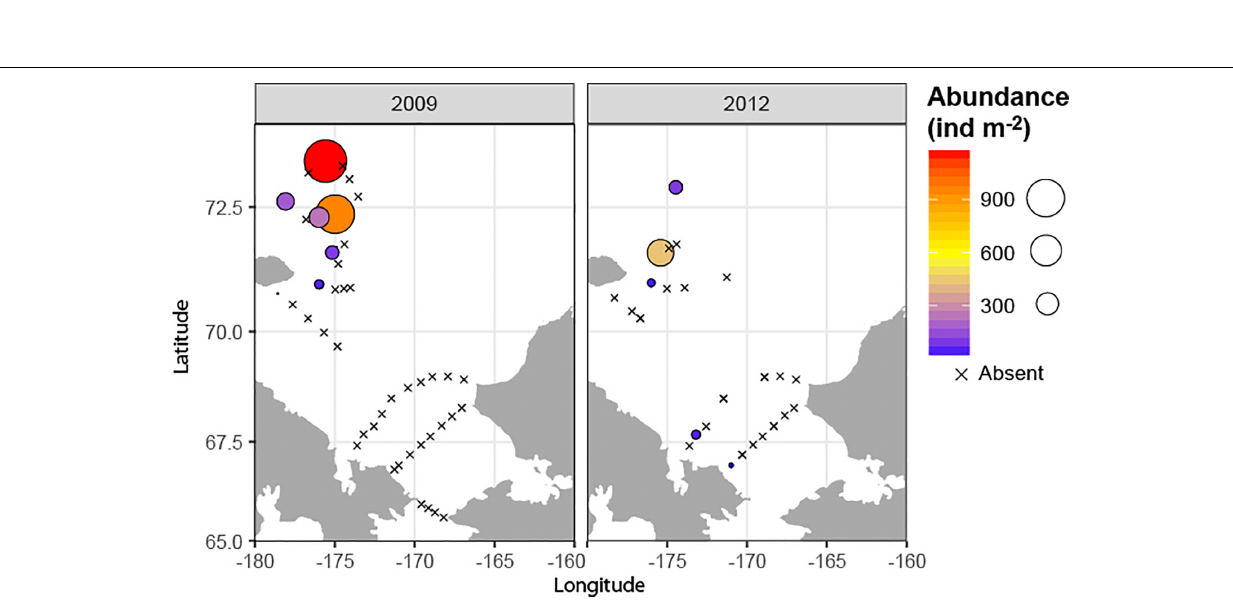
Frontiers in Marine Science |